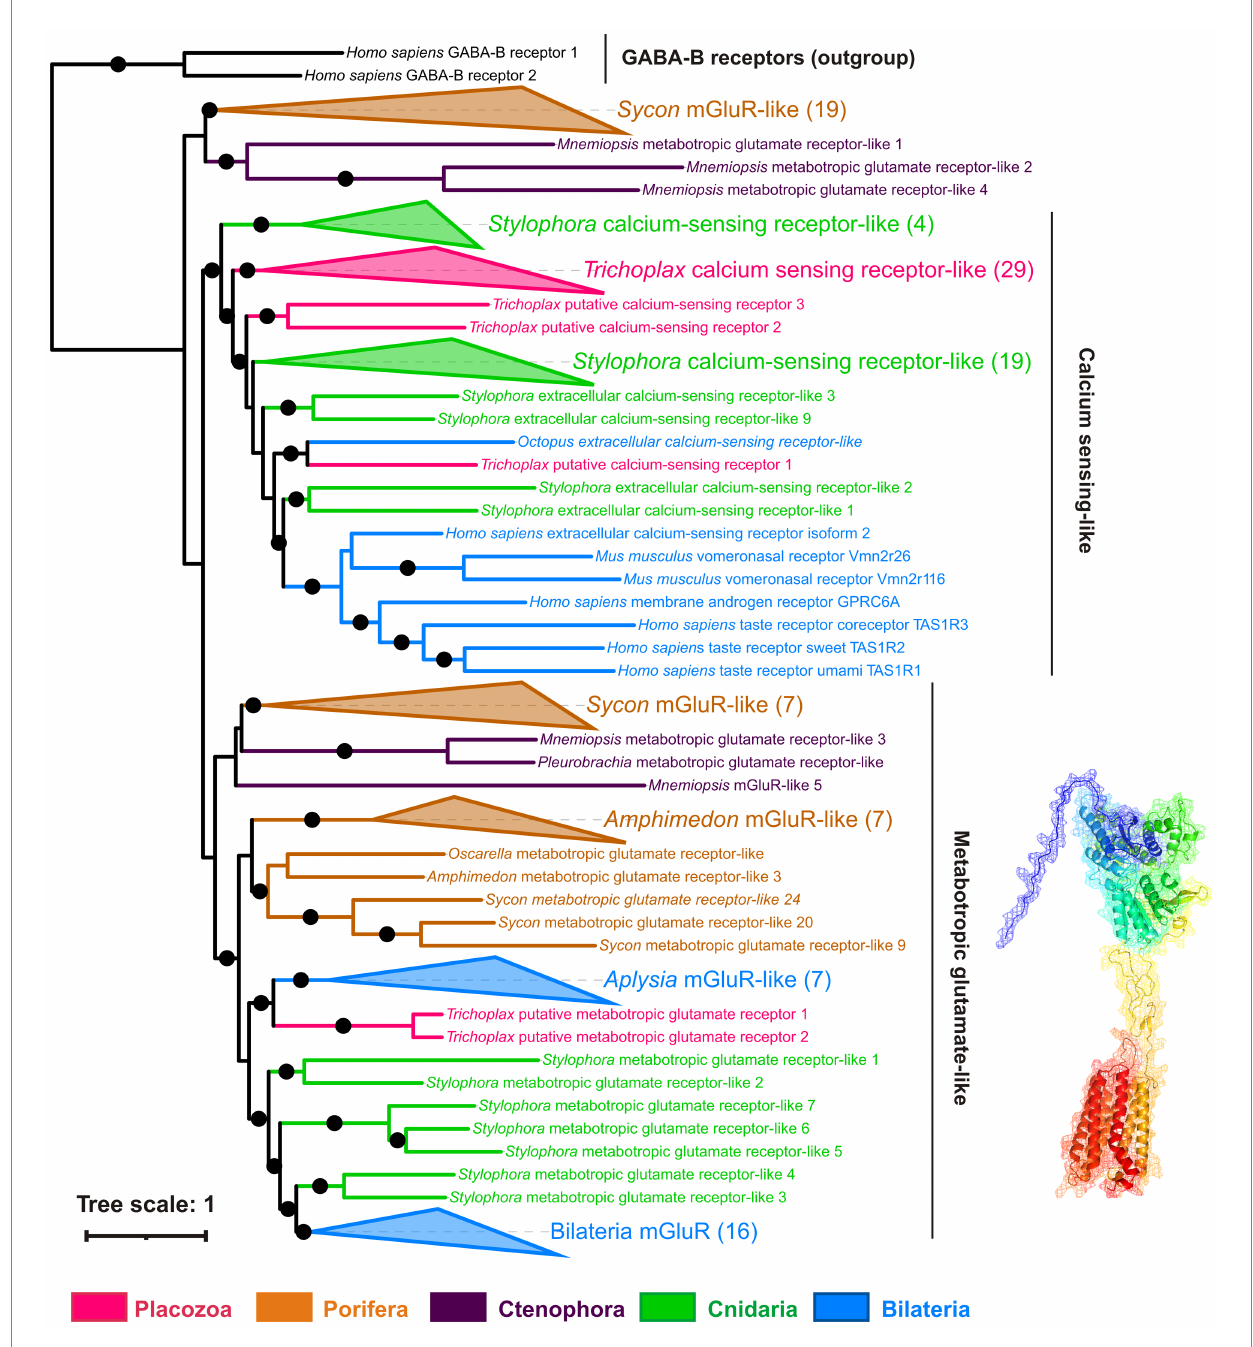
FIGURE 11 Phylogeny of metabotropic glutamate receptors (mGluRs): Trichoplax has 34 receptors of this highly diverse superfamily. Maximum likelihood tree shows mGluRs and related receptors such as extracellular calcium-sensing (CaSR), taste, and vomeronasal receptors. Trichoplax mGluR-related receptors form 4 separate clades in the tree. Two Trichoplax receptors are sisters to a clade of Aplysia mGluR-like receptors; the other three clades are more closely related to calcium-sensing, taste, and vomeronasal receptors. Similarly, cnidarians and calcisponge Sycon have numerous mGluR-like receptors (30 in Stylophora , 29 in Sycon ), forming several clades. This tree structure suggests that the divergence of mGluRs and CaSR-like receptors predates the radiation of basal metazoan phyla. Black dots mark highly supported nodes (bootstrap support > 0.75). Full uncollapsed trees with numeric support values can be found in Supplementary Figure